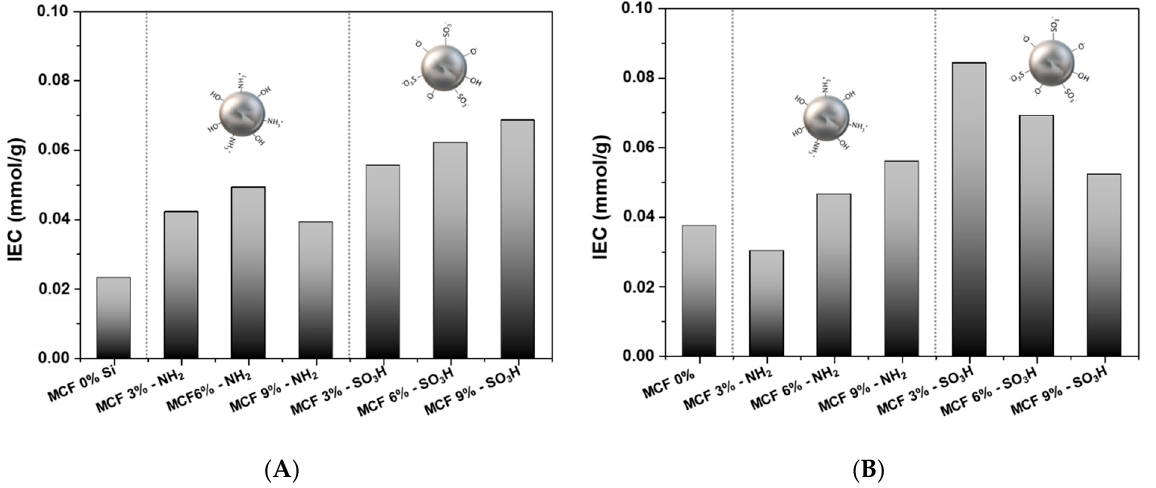
Figure 15. Measurements of ion exchange capacity (IEC) at 50 °C for membranes prepared from ( A ) HMW-sPEES and ( B ) LMW-sPEES.